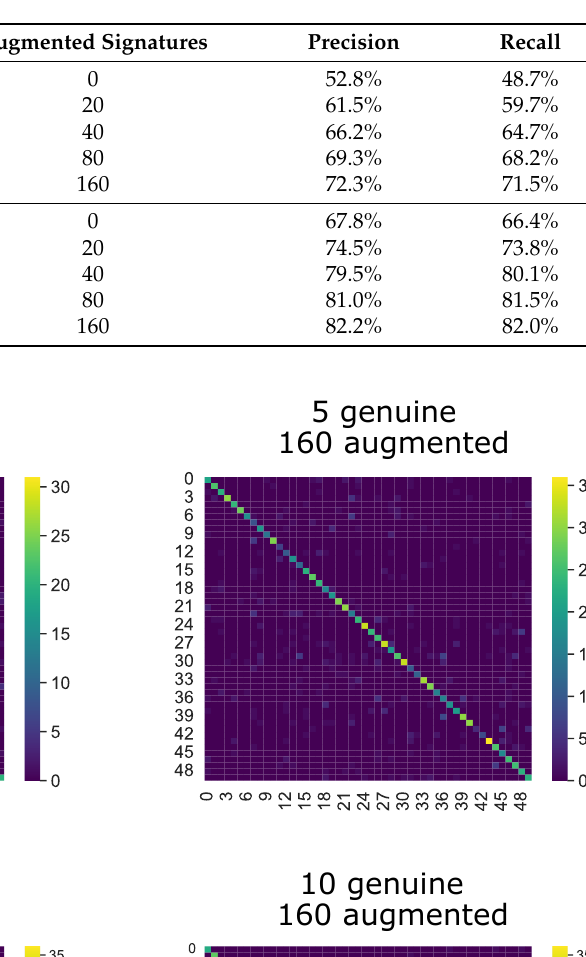
Table 2. Test set results using different number of genuine and augmented signatures in the train- ing set.